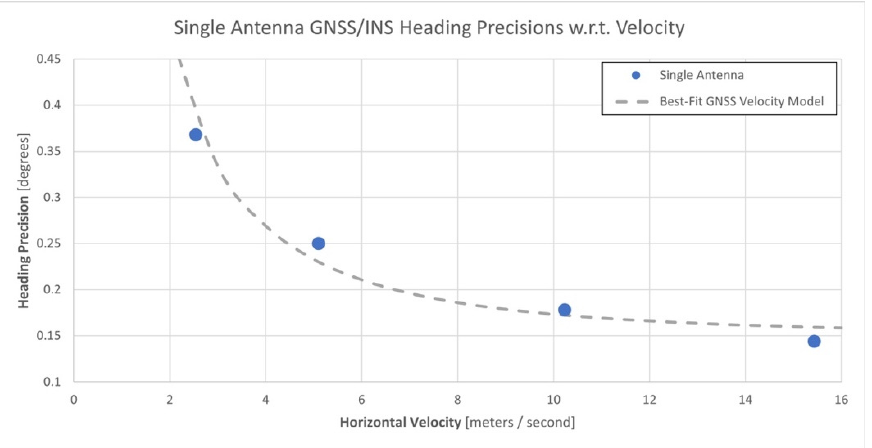
Figure 10. Single-antenna GNSS/INS heading precisions at the different horizontal velocities of the experiment best-fit to the theoretical GNSS velocity model.